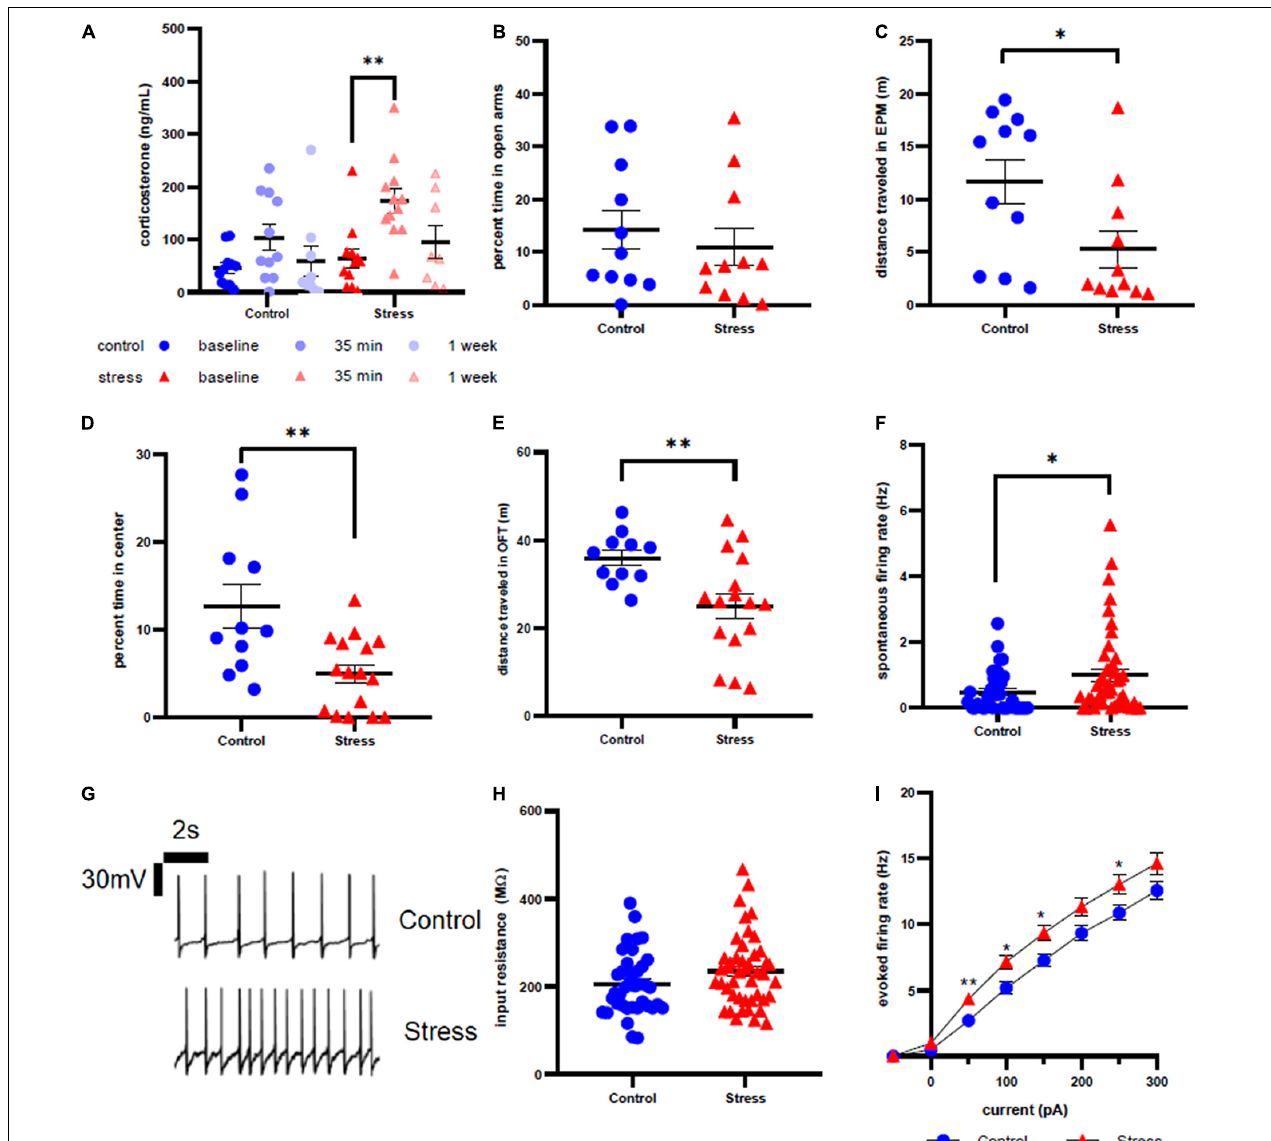
FIGURE 3 | Stress response in adolescent male rats. (A) Serum corticosterone concentration is higher 35 min after stress compared to baseline. (B) There is no effect of stress on time spent in open arms of the elevated plus maze immediately after stress or control conditions. (C) Stress decreases distance traveled in the elevated plus maze immediately after stress or control conditions. (D) Animals spend less time in the center of the open field test one week after stress compared to control. (E) Prior stress decreases distance traveled in the open field test. (F) Stressor exposure increases the spontaneous firing rate of LC neurons one week after stress. (G) Representative traces for spontaneous firing in control (top) and stress (bottom) groups. (H) There is no effect of stress on input resistance of LC neurons one week after stress. (I) Stress increases the excitability of LC neurons one week after stress. ∗ p < 0.05; ∗∗ p <